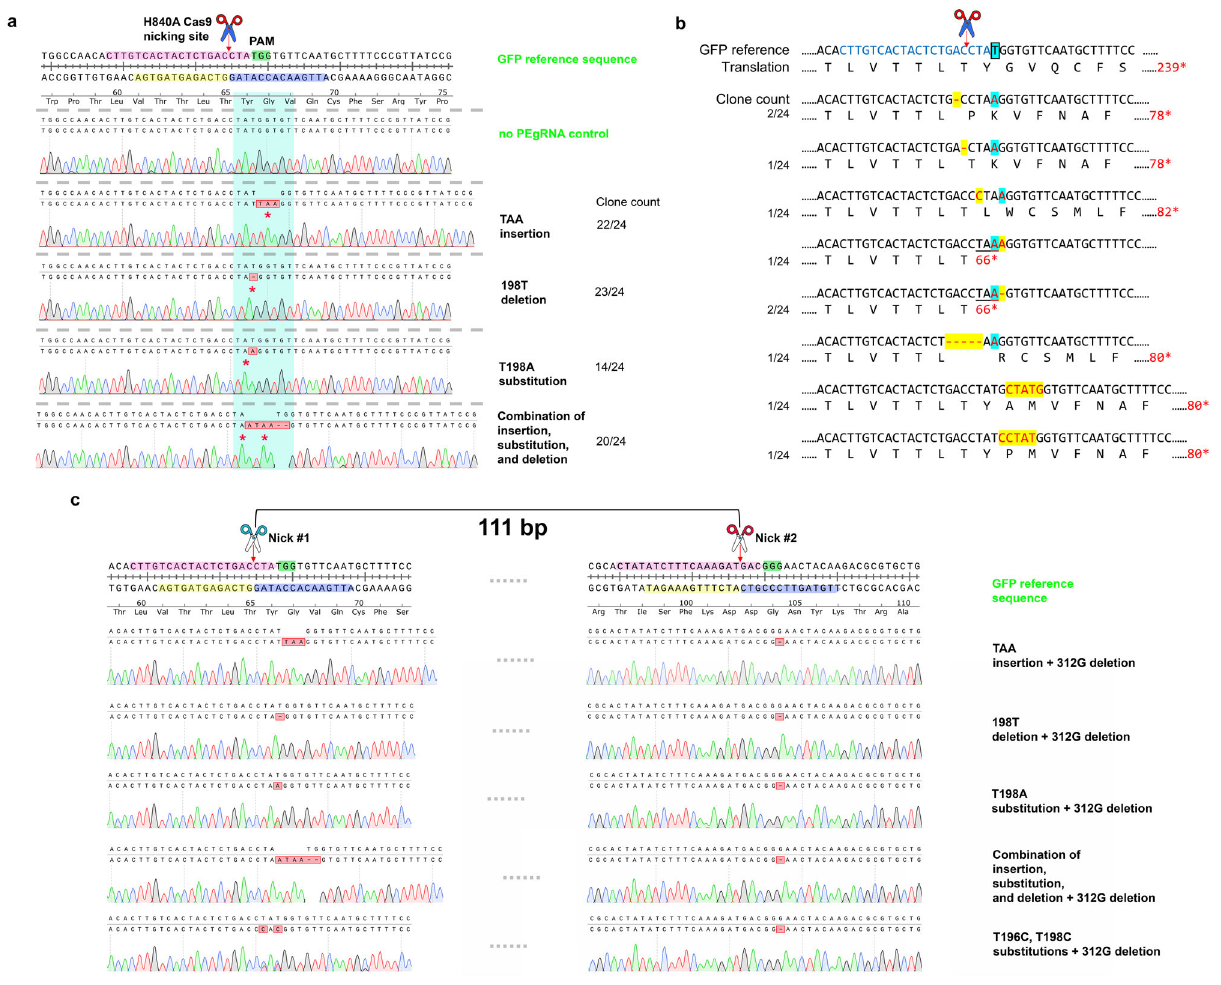
Fig. 2 Evaluation of plasmid-based editing by CRISPR-Prime Editing system using Sanger sequencing. Stop codon is displayed as an asterisk under the nucleotide sequences, the potential Cas9 H840A nicking site is indicated by a red arrow. The 20 nt protospacer, the PAM sequence, the PBS, and the RTT are highlighted in pink, green, yellow, and blue, respectively; while the cyan masked Sanger sequencing traces show the sequence to be replaced by the RTT that will contain the different edits designed. a Twenty-four randomly picked colonies of each designed DNA engineering were Sanger sequenced and traces were aligned to the targeted locus of the GFP coding sequence. The correctly edited clone numbers and the total sequenced clone numbers are shown on the right of the fi gure. b Shown are the recorded target-speci fi c unintended edits of the 1 bp substitution. The target T is boxed and masked in light blue. The GFP reference DNA sequence and the translated amino acid sequences are show on the top row. The corrected edited nucleotide is in red and masked with light blue, while the unexpected mutations (off-target) are in red and masked with yellow. The recorded off-target clone numbers and the total sequenced clone numbers are shown on the left of the fi gure. c Sanger sequencing traces of the successfully dual-edited clones by CRISPR-Prime Editing. Two nicks are 111 bp away, the left nick (nick #1) is introduced by pPEgRNA (ColE1 ori), and the right nick (nick #2) is introduced by pVRb_PEgRNA (pSC101 ori). The combinations of 3 bp insertion, 1 bp deletion, 1 bp substitution, 2 bp substitution, combinatory editing, and 1 bp deletion are